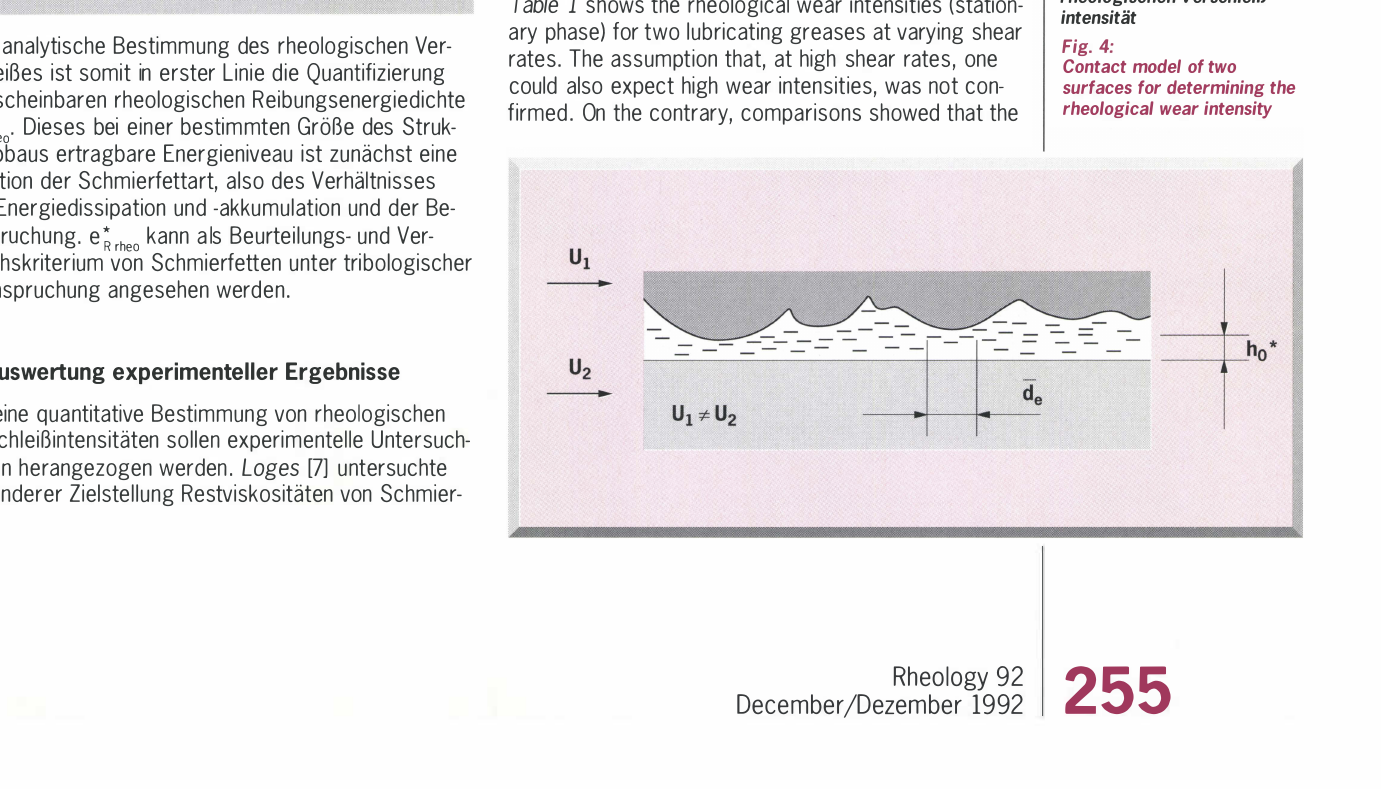
Fig. 4: Contact model of two surfaces for determining the rheological wear intensity